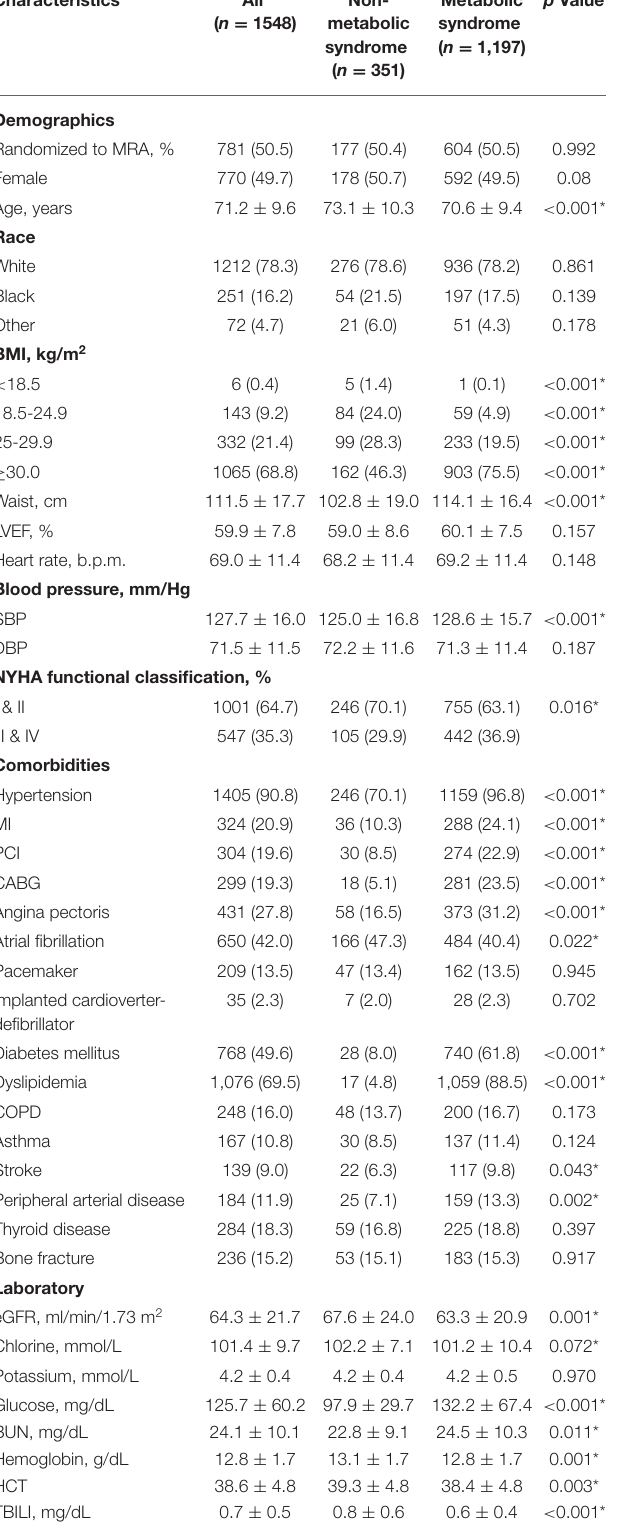
TABLE 1 | Characteristics of patients with and without metabolic syndrome.